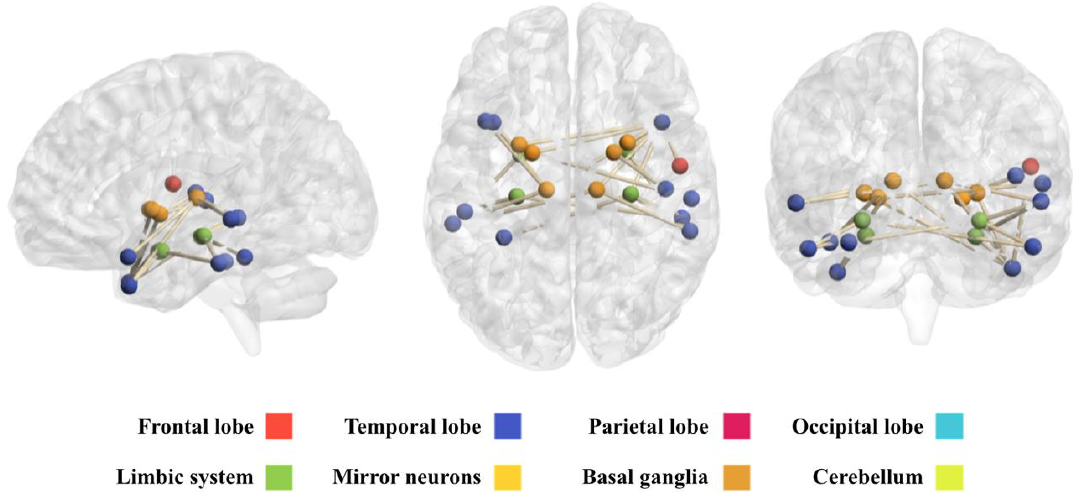
Figure 4. Representation of the network obtained under the overconnectivity hypothesis. From left to right: sagittal, axial and coronal views of the brain. Representation obtained with the BrainNet Viewer Toolbox [21].